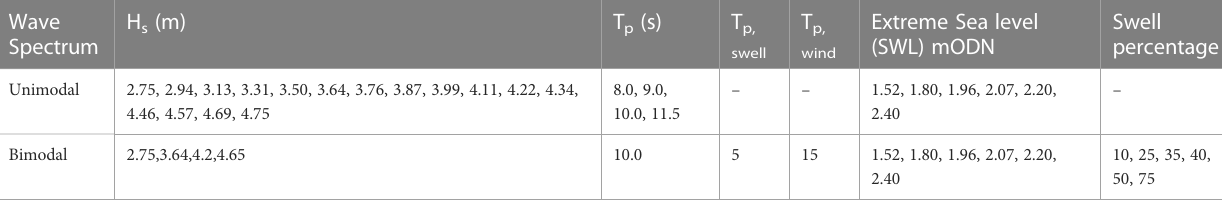
Figure 5C1 indicates approximately a 1 m reduction in crest height following this storm. According to Figure 5C2, while sediment eroded from the barrier face continued to accumulate at the lower shoreface during the storm, some sediment was transported to the back of the barrier. During the initial period of is eroded. This eroded sediment is transported and accumulated offshore on the lower beach face. This corresponds to collision regime . As the storm progresses and the water level increases towards the peak, the barrier crest height gradually reduces as does the width of the barrier crest, due to overwashing which carries sediment over the crest of the barrier and deposits it landward, this corresponds to discrete overwash regime . However, after the slight landward movement of the barrier crest during the early stages of the storm, its horizontal position remains stable during the latter part of the storm. The reduction in crest height is followed by multiple run-up events exceeding the crest of the barrier (Figure 5C3). The reduction of the barrier crest height is